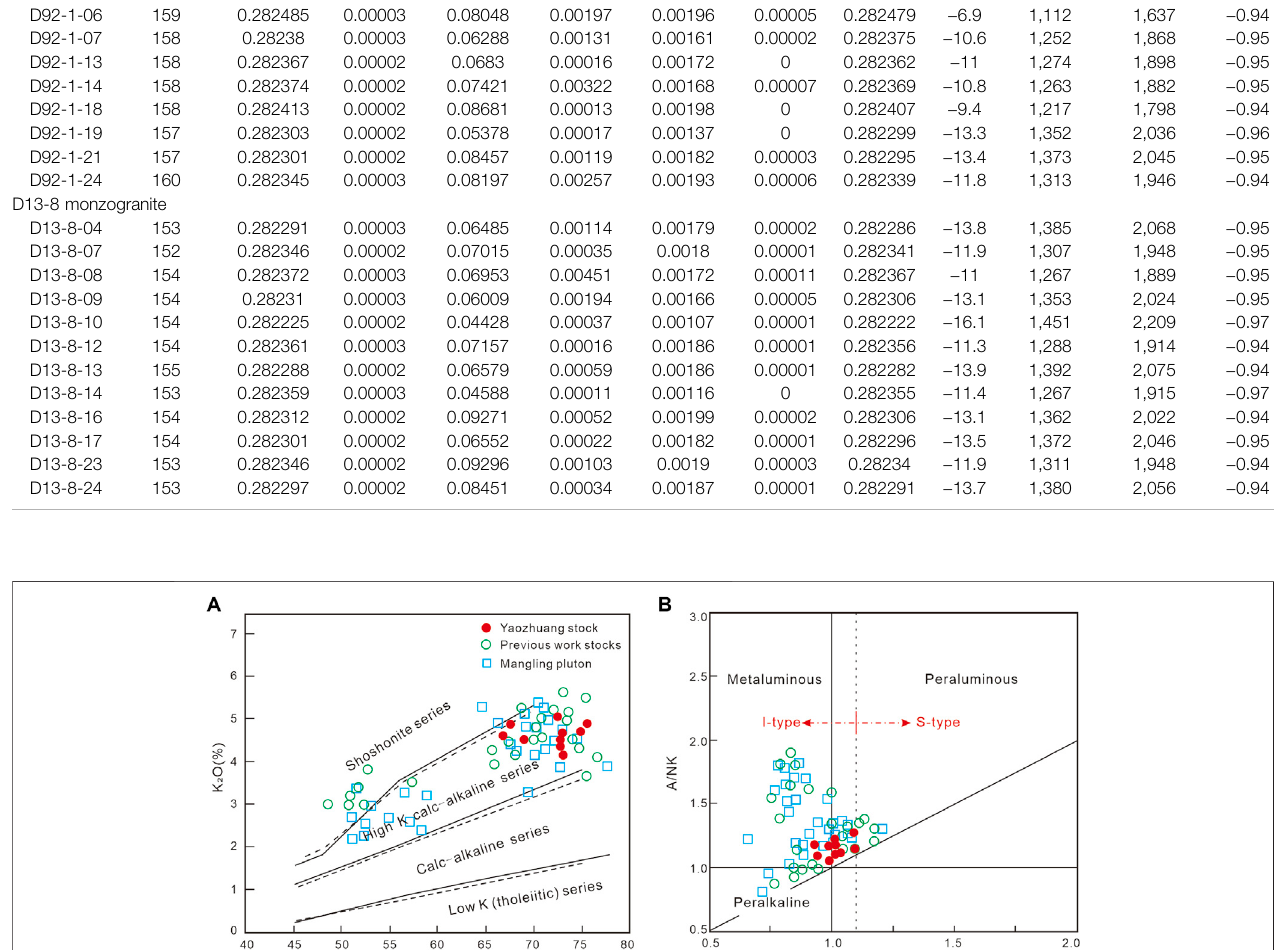
Frontiers in Earth Science |